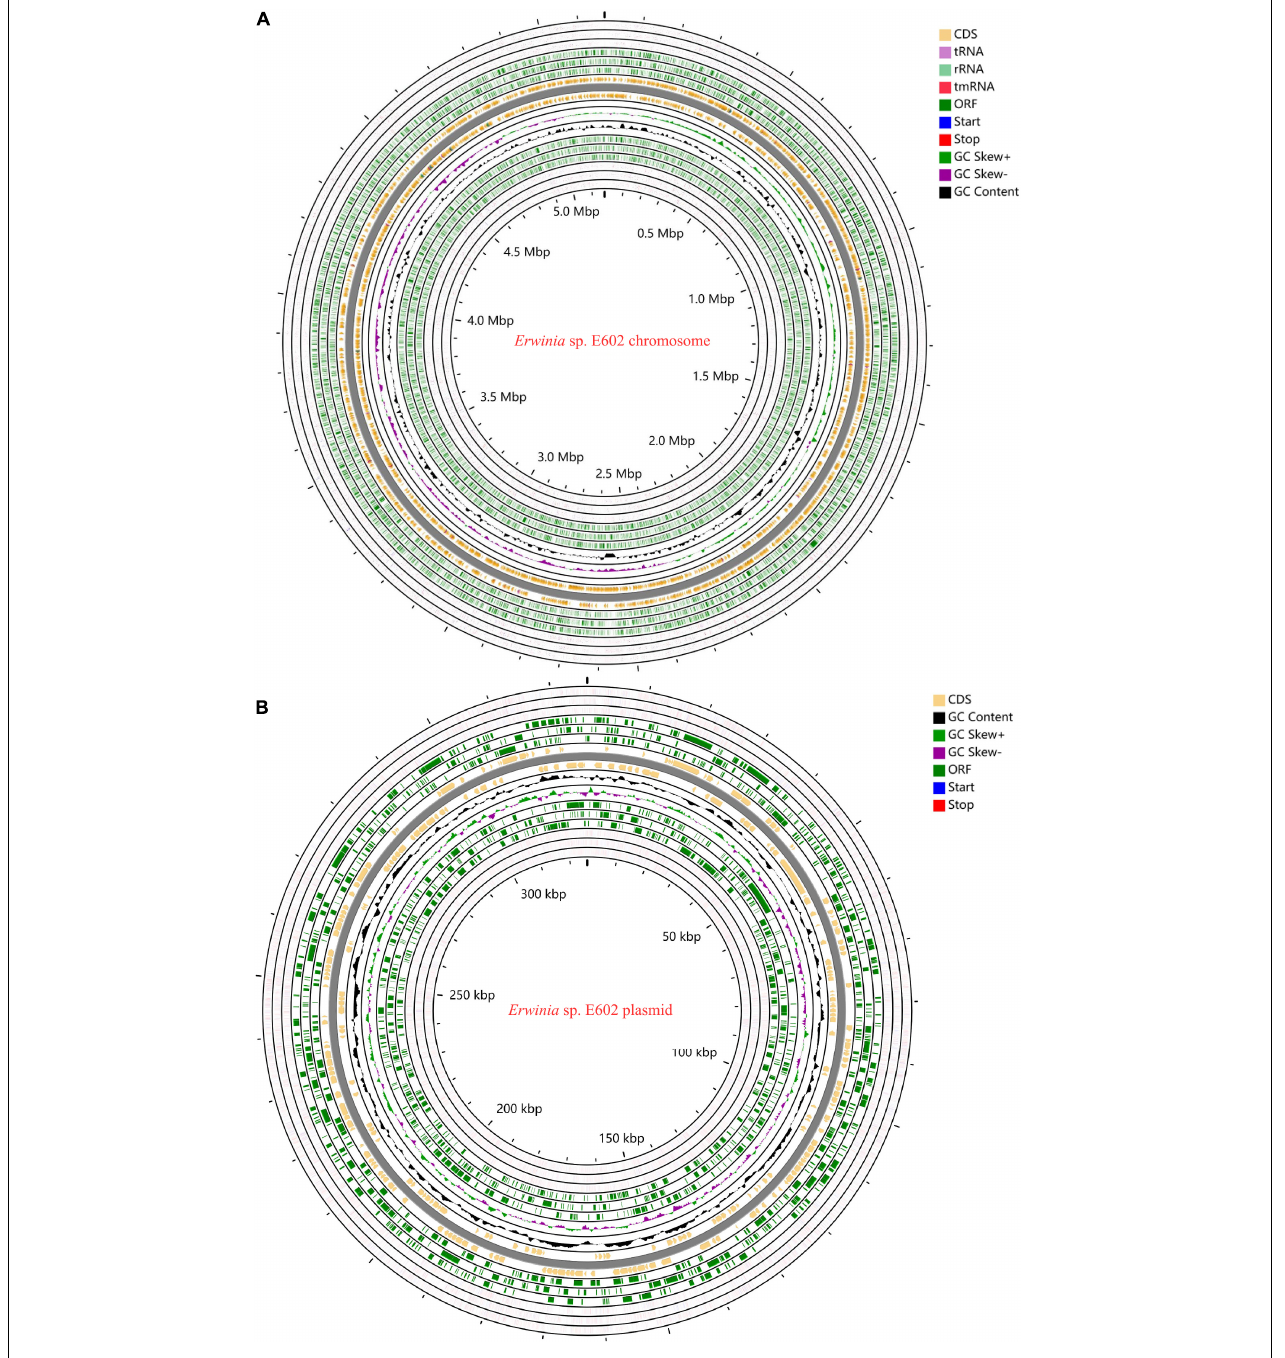
FIGURE 1 | Circos plots of the annotated genome of Erwinia sp. E602. Two circular DNA, including the chromosome (A) and a large plasmid (B) are shown. Different colors represent CDS, rRNA, tRNA, tmRNA, Start, Stop, ORF, GC content, GC Skew+, and GC skew-